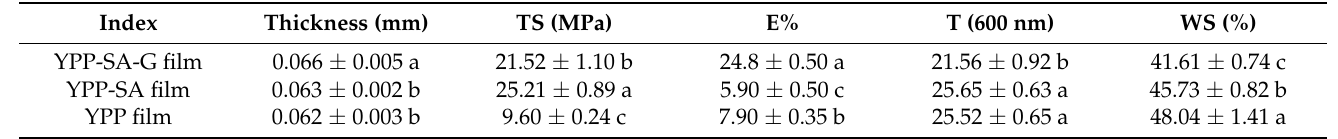
Table 7. The physical properties of the YPP, YPP-SA, YPP-SA-G